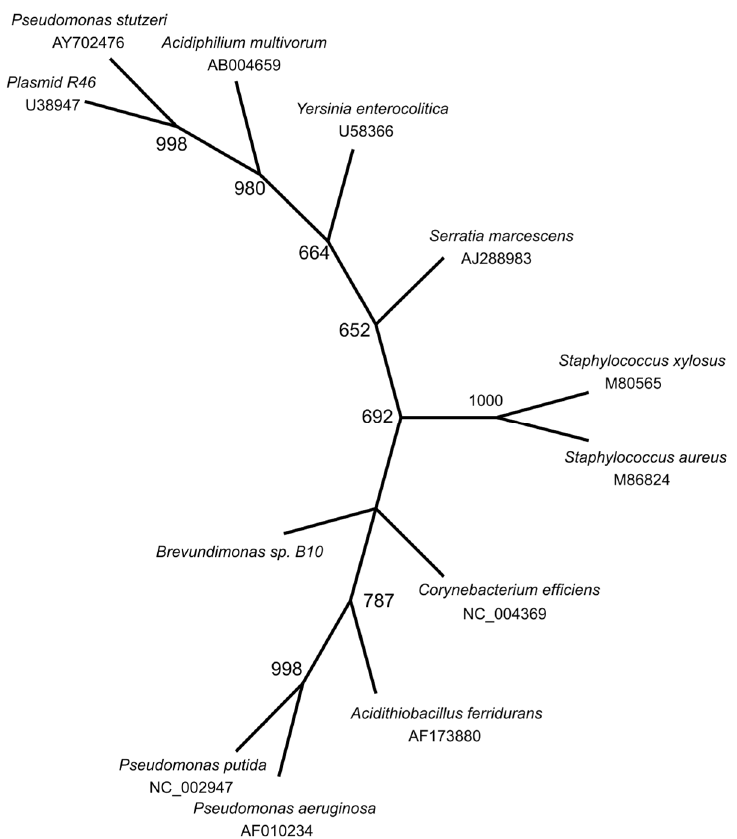
Figure 1. Phylogenetic tree of the arsR , arsB , and arsC genes of Brevundimonas sp. B10 and other bacterias containing the ars operon using WAG + G model by Maximum Likelihood over 526 informative positions. The stability of the tree was evaluated by the bootstrap method with 1000 rep- lications.